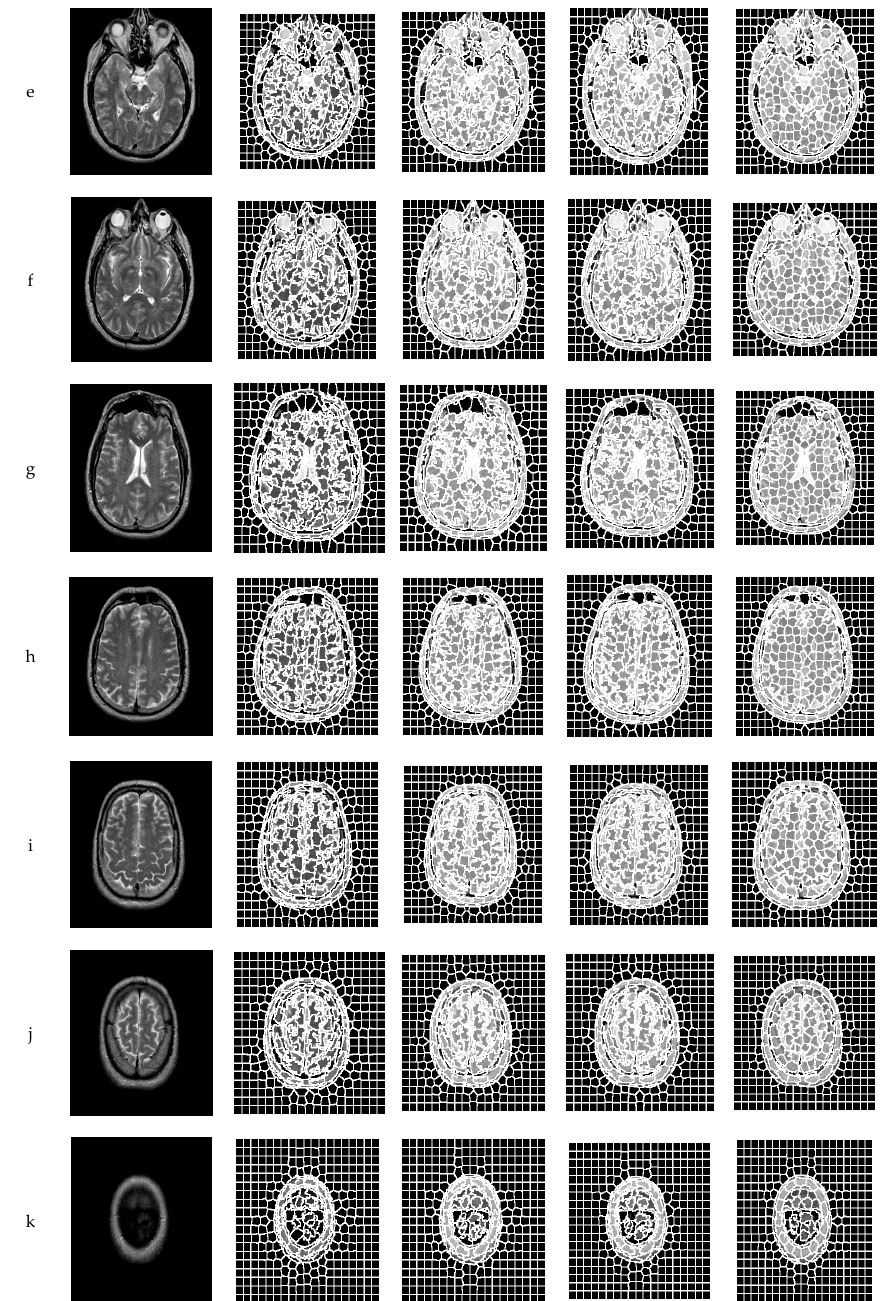
Figure 5. The segmentation results of different algorithms. Compared with SLIC, improved SLIC greatly improved the accuracy of superpixel segmentation and the consistency of superpixel blocks. As can be seen from Figure 5, after adding the local texture features of the image, the image features are better when calculating the similarity between pixels, and the pixels grouped into the same superpixel have more similar features. The superpixel edge of the proposed algorithm coincides with the edge of the target area in the image. The target areas close to the gray value of the background area and the smaller target areas that are misclassified are also significantly reduced. The superpixel blocks are more uniform and regular, and the accuracy of superpixel segmentation and the consistency in the superpixels are further improved in the proposed